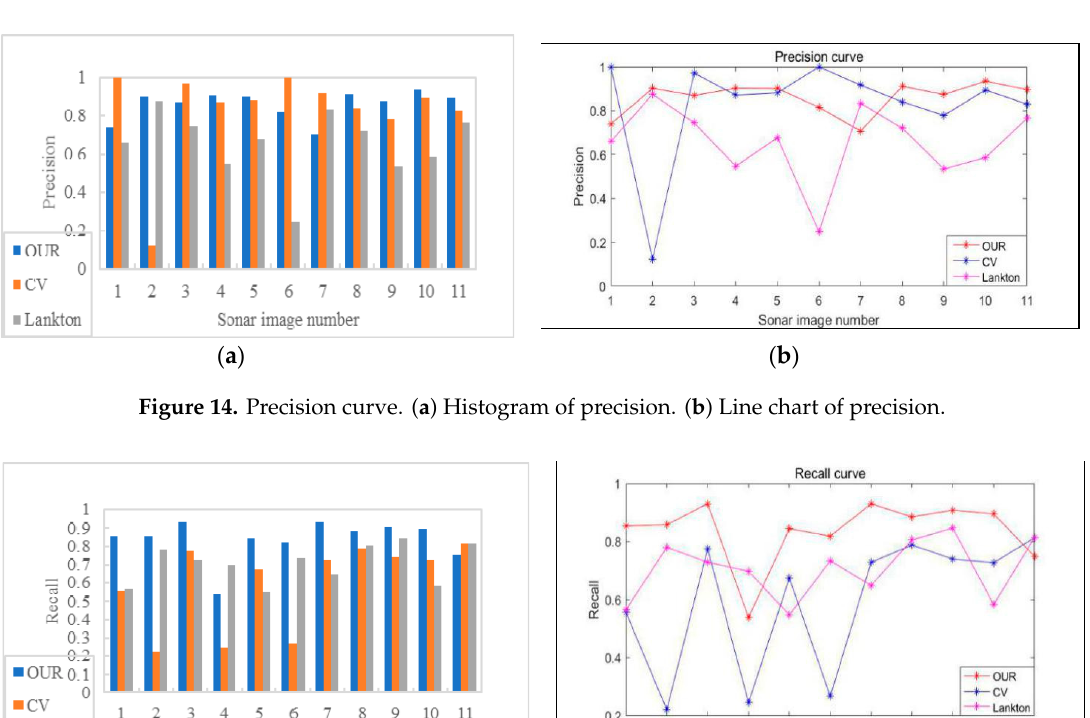
Figure 13. Jaccard curve. ( a ) Histogram of Jaccard. ( b ) Line chart of Jaccard.